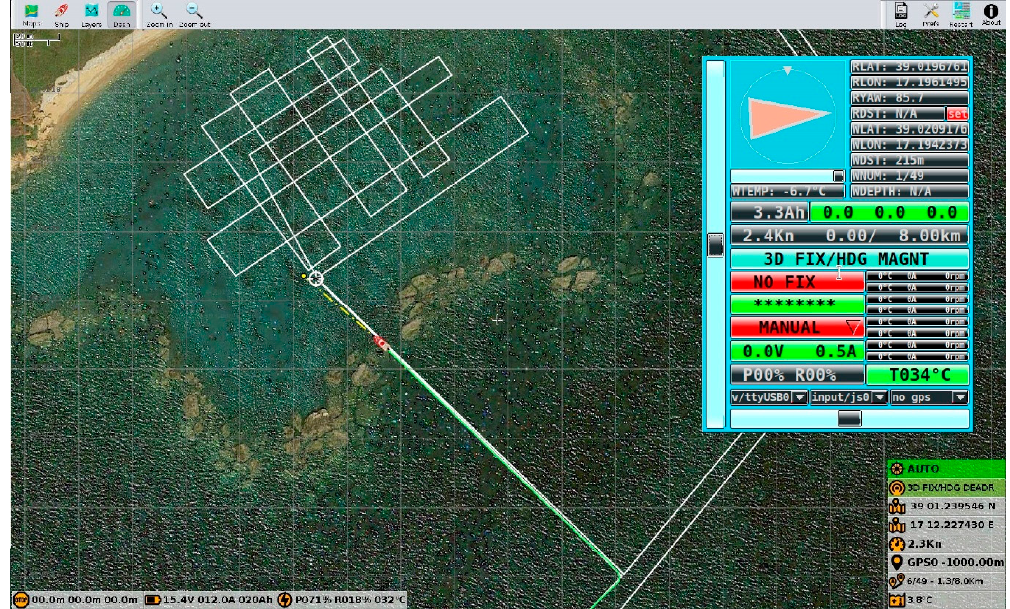
Figure 7. Screenshots of OSN and SwapController ( inset ) during a survey. Planned lines are marked in white, while navigation performed is indicated by green lines. white, while navigation performed is indicated by green